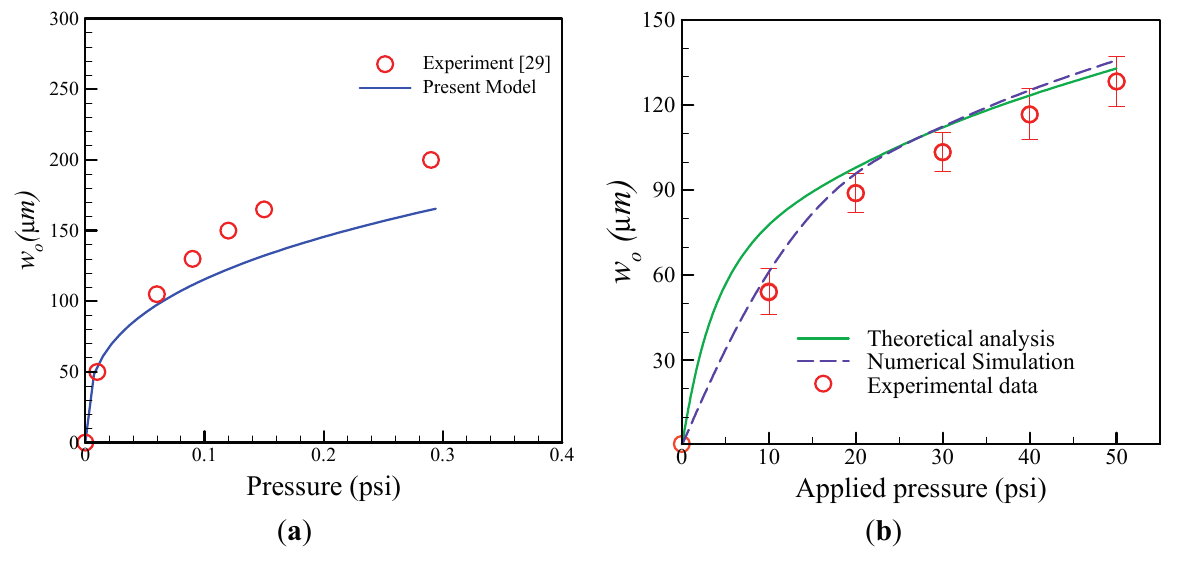
Figure 6. Numerical deformations of ( a ) the x -directional; and ( b ) y -directional displacements at 50 psi.